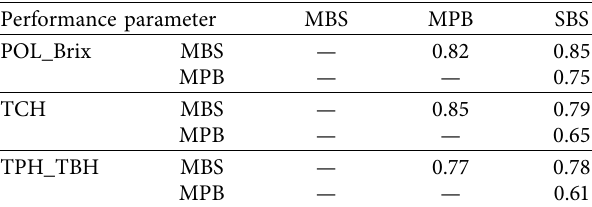
Table 8: Pearson’s correlation coefficients between average per- formance parameters for 29 genotypes across three different planting material types, using predicted genotypic differences (PDG) from Tables 5 to 7, for each performance